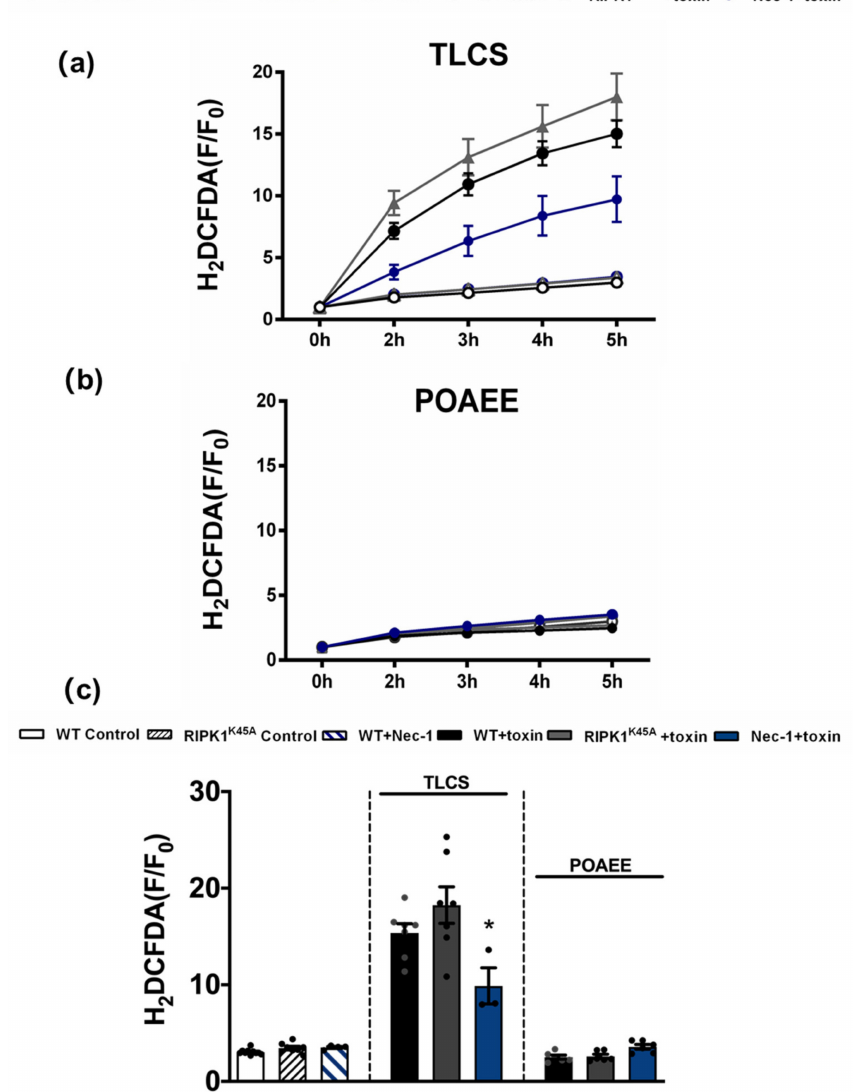
Figure 6. Inhibitory effects of Nec-1 on intracellular ROS in PACs. Line graphs showing the effects of RIPK1 K45A modification and Nec-1 (30 µ M) on intracellular ROS levels (H 2 DCFDA) in the presence of ( a ) TLCS (500 µ M) and ( b ) POAEE (100 µ M). ( c ) Bar graph showing the endpoint effects of RIPK1 K45A modification and Nec-1 on intracellular ROS levels at 5 h in the presence of TLCS and POAEE. Each dot represents a mouse. Changes are normalized increases in fluorescence from the baseline (F/F 0 ) and data expressed as the mean ± SEM ( n ≥ 3 mice/group; n.b. some traces have overlap and the symbols are masked). Significant differences in Nec-1 from WT controls are shown as * p <